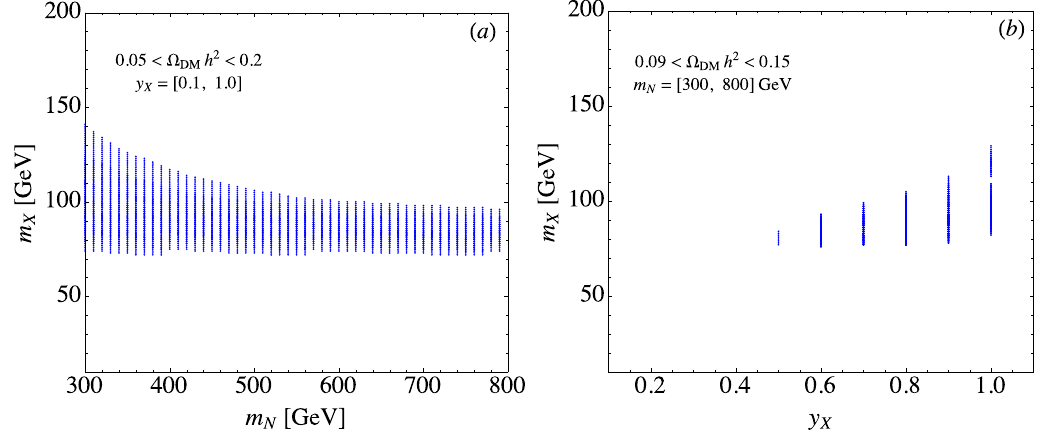
Figure 3 . Allowed parameter space, which can produce the DM relic density in the region of 0 : 09 < (cid:10) DM h 2 < 0 :